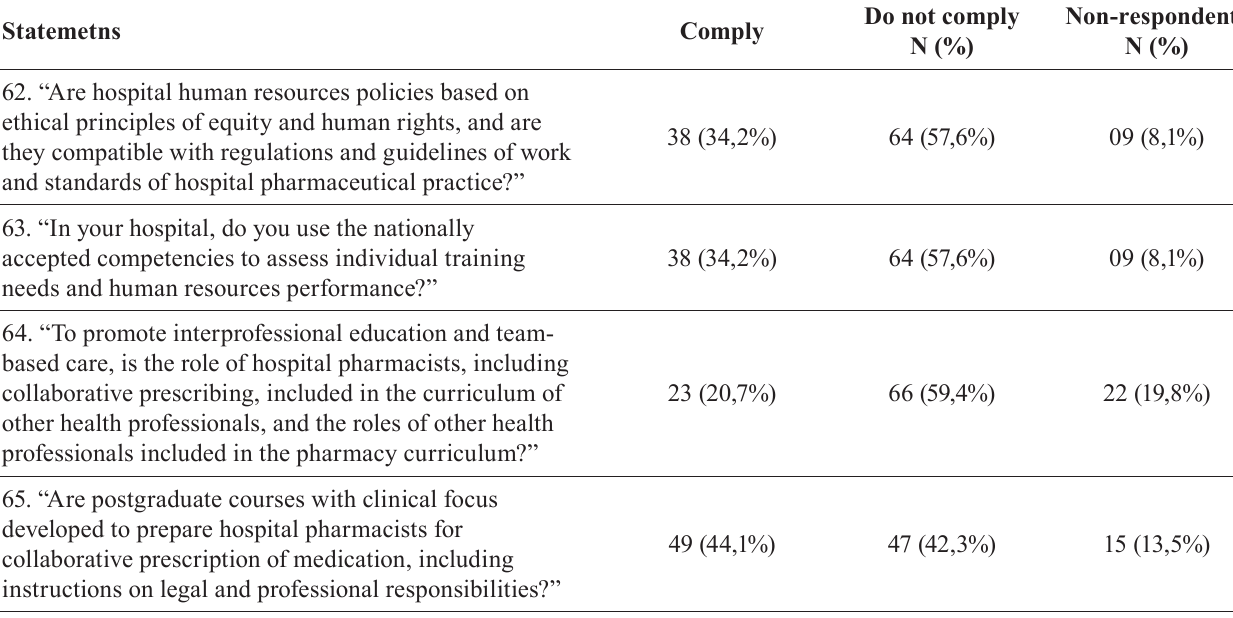
Table II - Evaluation of human resources, training and development of hospital pharmacies (N = 111)